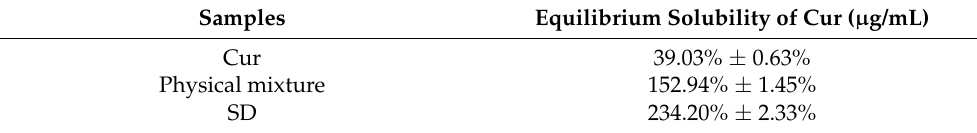
Table 2. The equilibrium solubility of Cur (mean ± RSD, n =